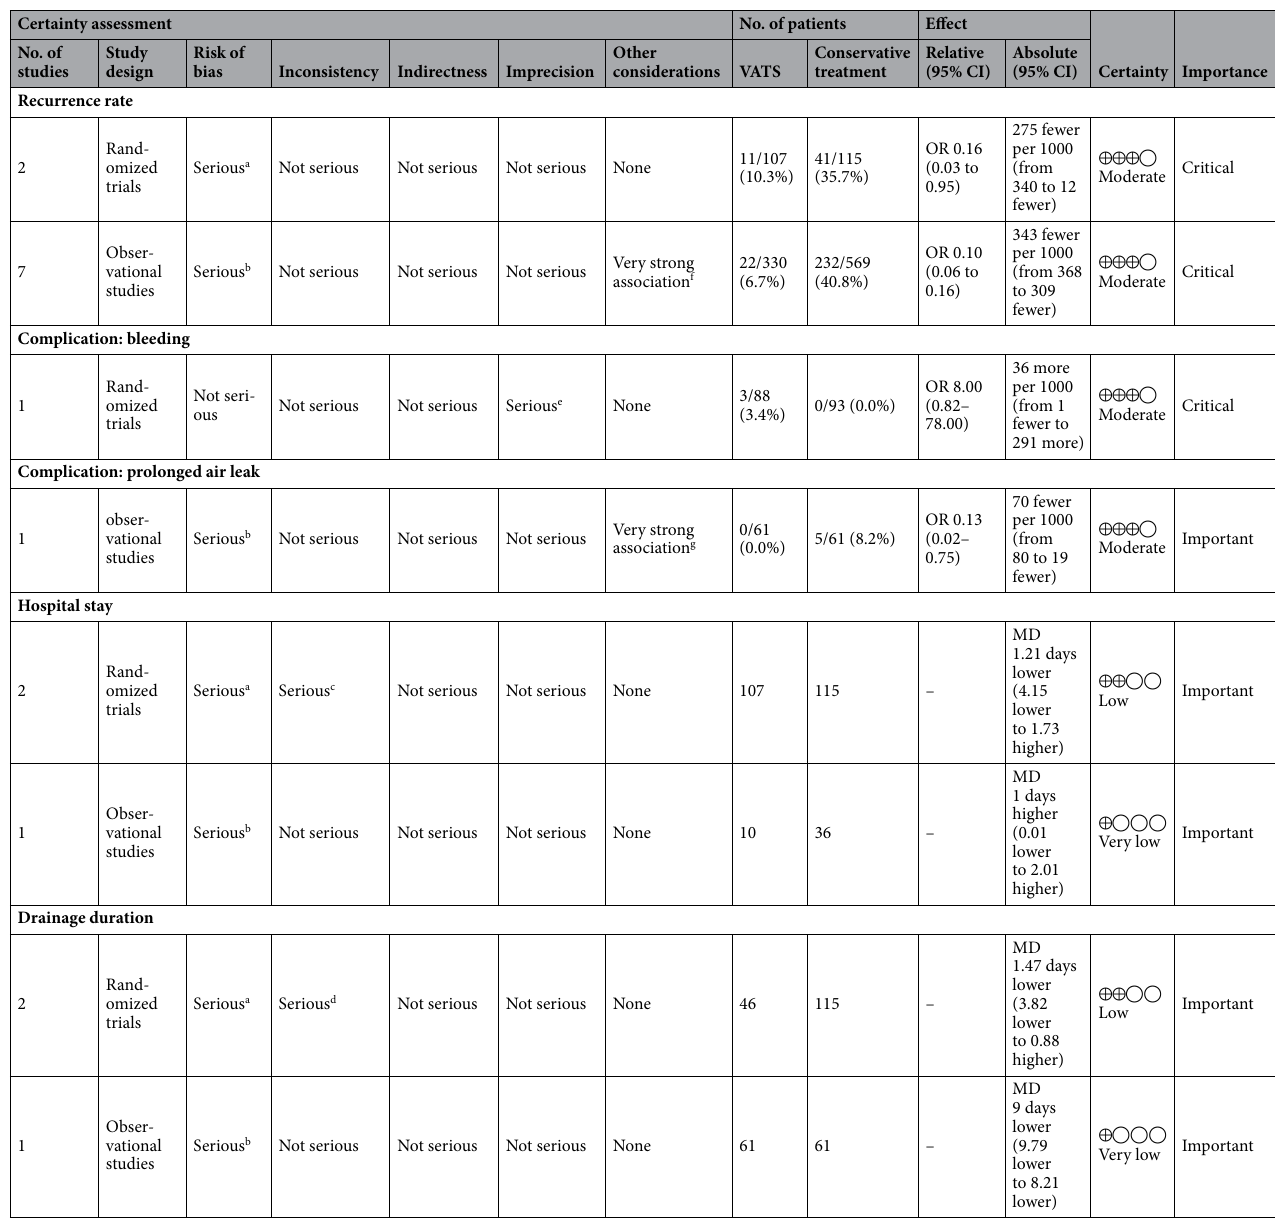
Table 2. VATS compared to conservative treatment for the first episode of primary spontaneous pneumothorax. Factors downgrading the quality include risk of bias, inconsistency, indirectness, imprecision, and publication bias, whereas factors upgrading the quality include large effect, plausible confounding, and dose–response. The quality of evidence is classified as “very low,” “low,” “moderate,” or “high” . CI confidence interval, OR Odds ratio, MD mean difference. a Risk of bias: Al-Mourgi et al. (2015): high ROB. b Risk of bias: Divisi et al. (2015) and Seguier-Lipszyc et al. (2011): high ROB. c Inconsistency: hospital stay I 2 : 96%. d Inconsistency: duration drainage I 2 : 97%. e Imprecision: the clinical decision would differ due to the upper or the lower boundaries of the CI [OR 8, 95% CI 0.82 to 78], which represented the surgical bleeding. f The effect was very large due to the OR is 0.10 which is less than 0.2. g The effect was very large due to the OR is 0.13 which is less than